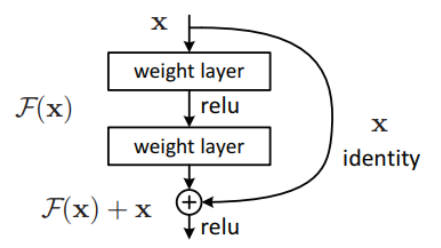
Figure 4. Building block of ResNet [19].